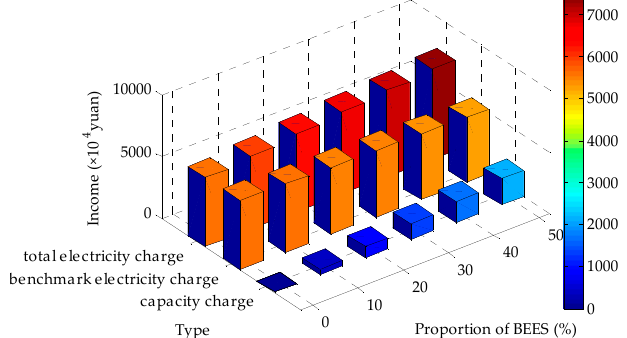
Figure 11. Comparison of the capacity charge and the benchmark electricity charge of the 50 MW PV plant with different proportions of energy storage.